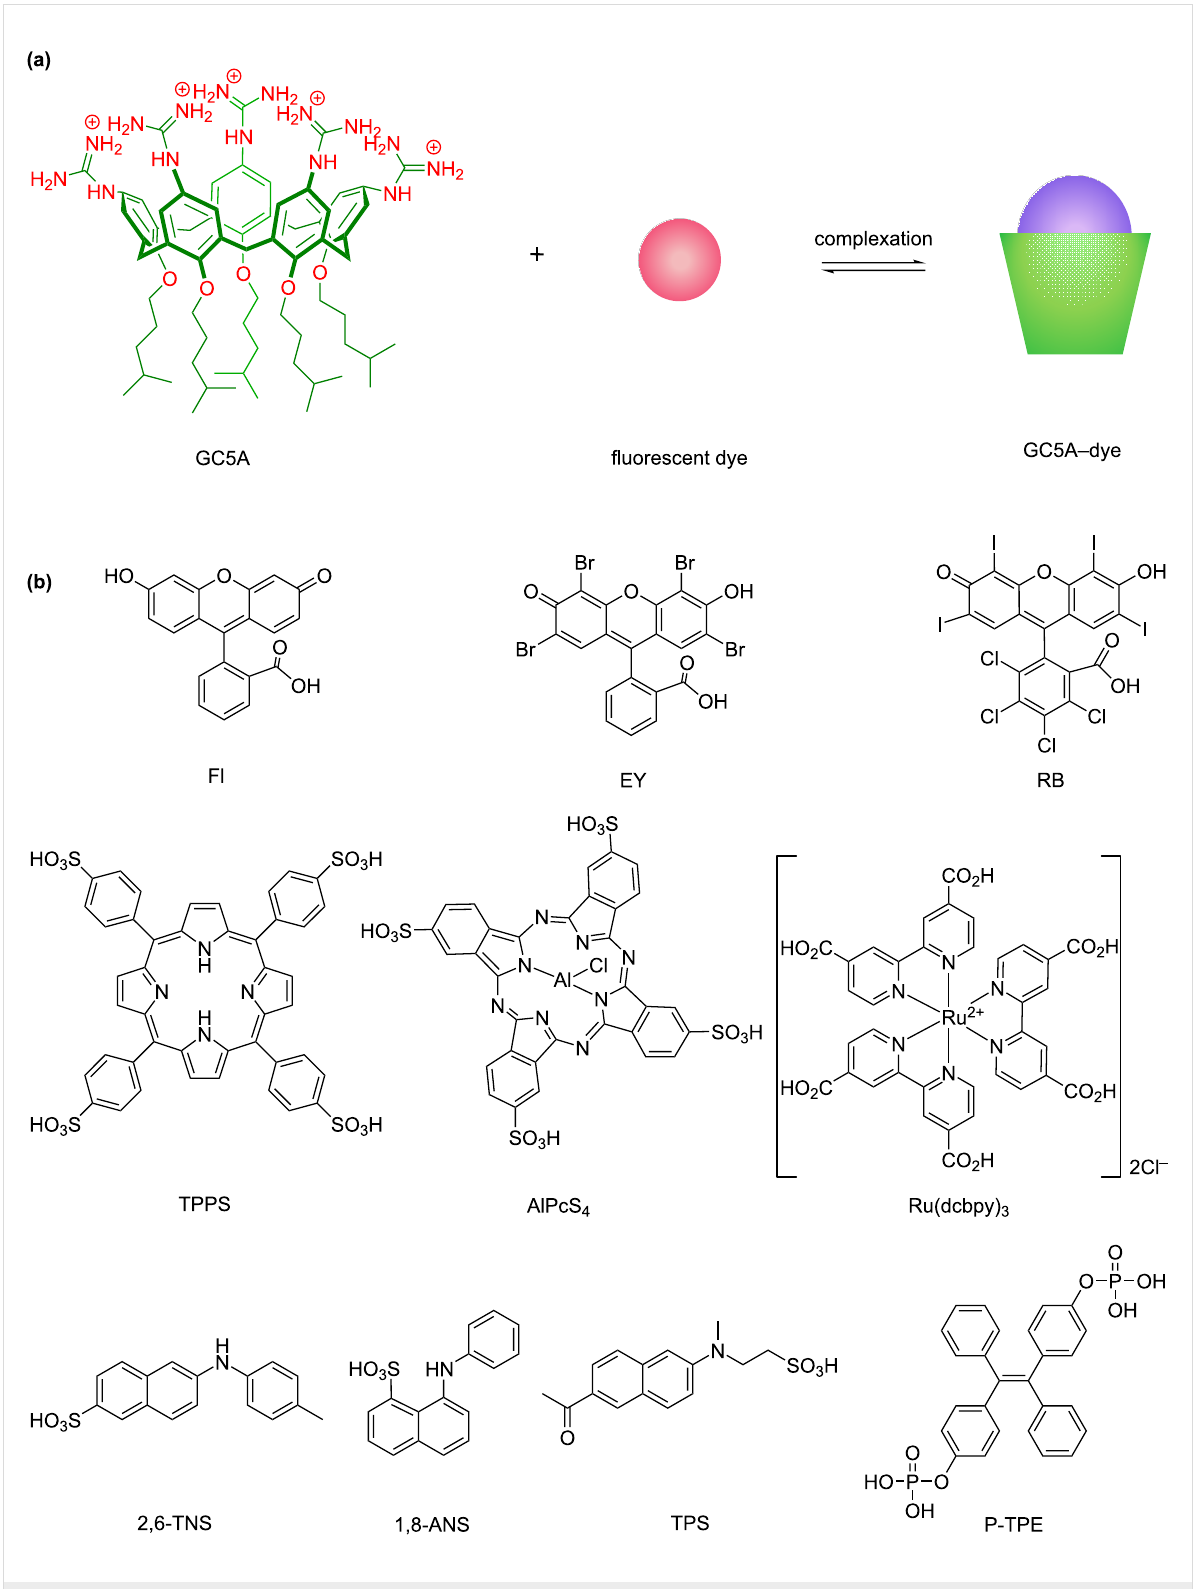
Scheme 2: (a) The chemical structure of GC5A and schematic illustration of the binding between the luminescent dye and GC5A. (b) Chemical struc- tures of luminescent dyes employed in this